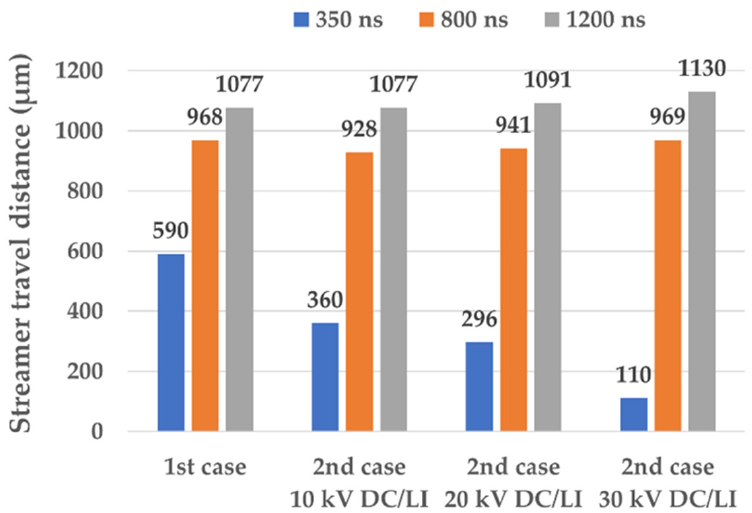
Figure 18. Streamer travel distance ( μ m) at three instants in the 1st and 2nd cases.